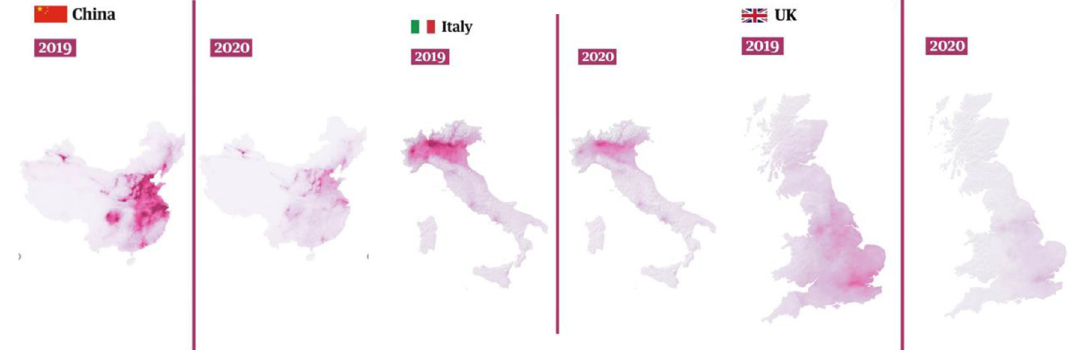
Fig. 2. Satellite photos for the level of air quality over the